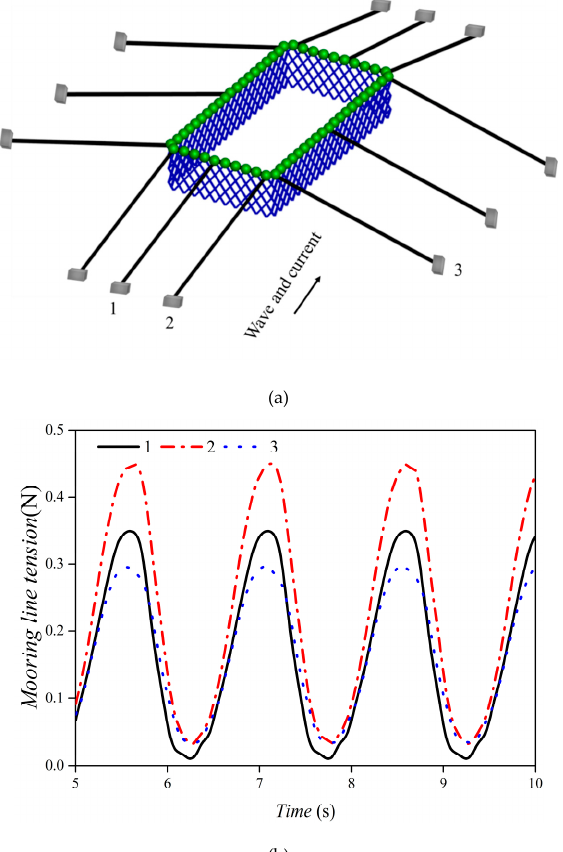
Figure 11. Comparison of mooring line tension for di ff erent mooring lines: ( a ) Diagram of mooring line number, ( b )Time history of mooring line tension.